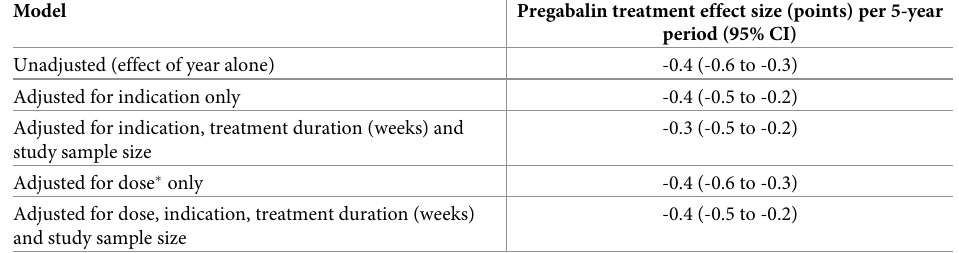
Table 1. Meta-regression results for the association between treatment effect size and year for unadjusted, par- tially- and fully-adjusted models.